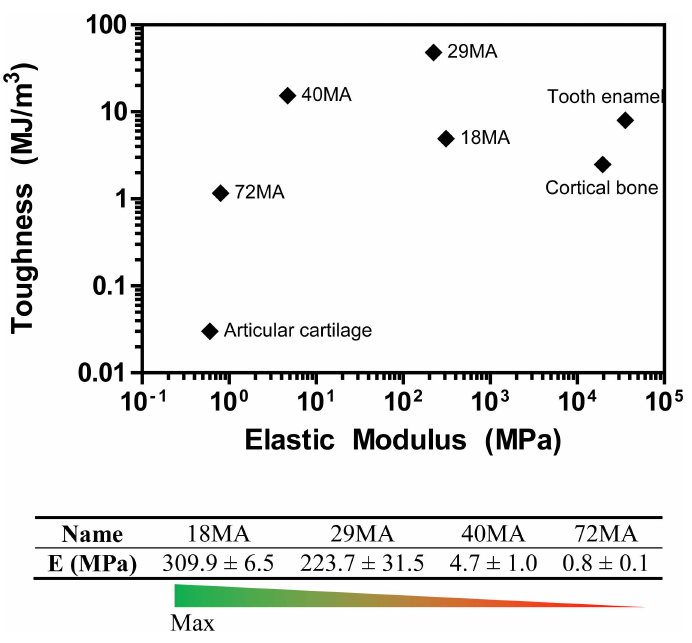
Fig 2. Toughness vs. elastic modulus for load-bearing biological tissues (green) and MA-MMA networks (black). Modifiedfrom data from